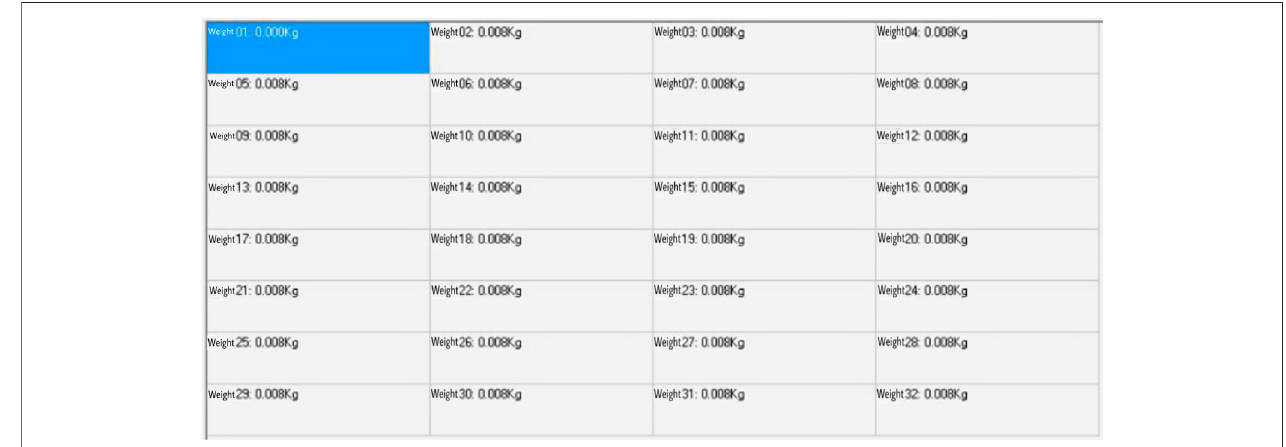
FIGURE 5 | Data display of the acquisition